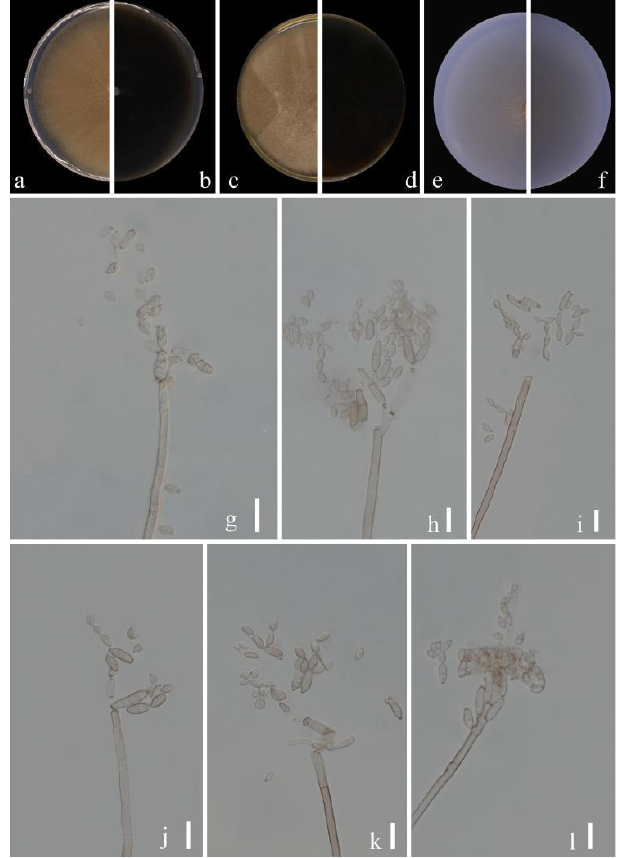
Figure 4. Cladosporium kaiyangensis (HGUP 21265, holotype). ( a , b ) Culture on PDA from